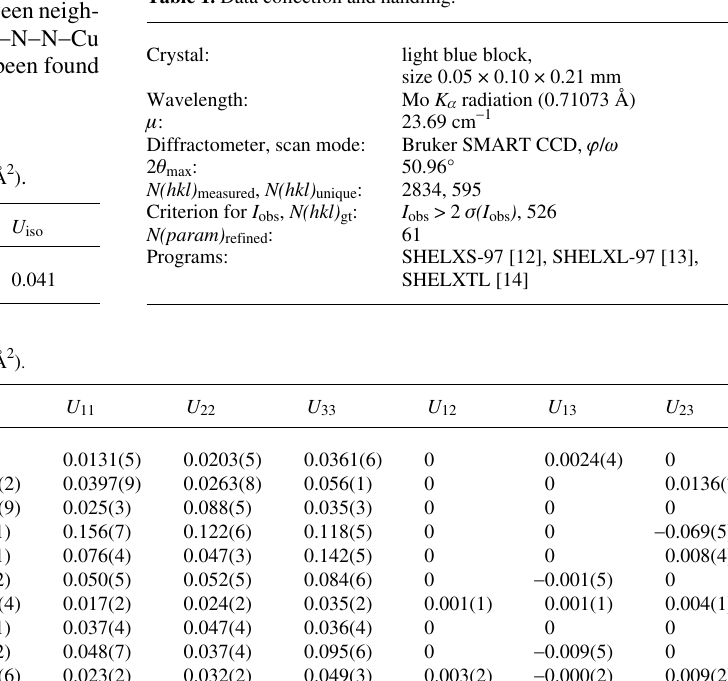
Table 1. Data collection and